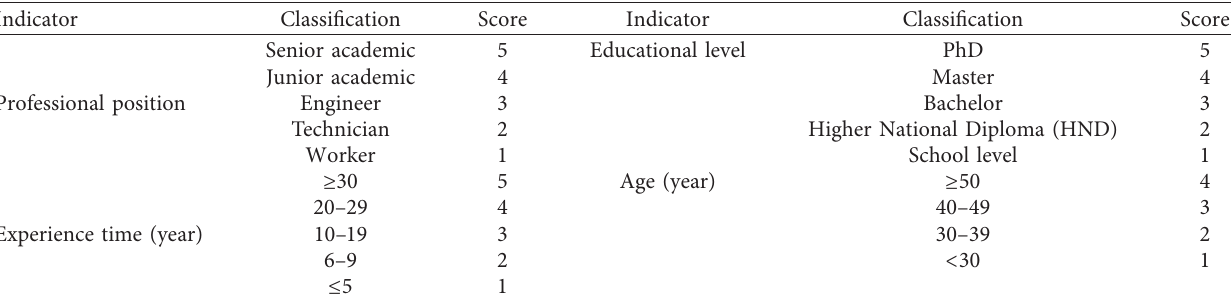
Figure 2: BN model of the project portfolio resource risk. Table 4: Weight score of different experts.